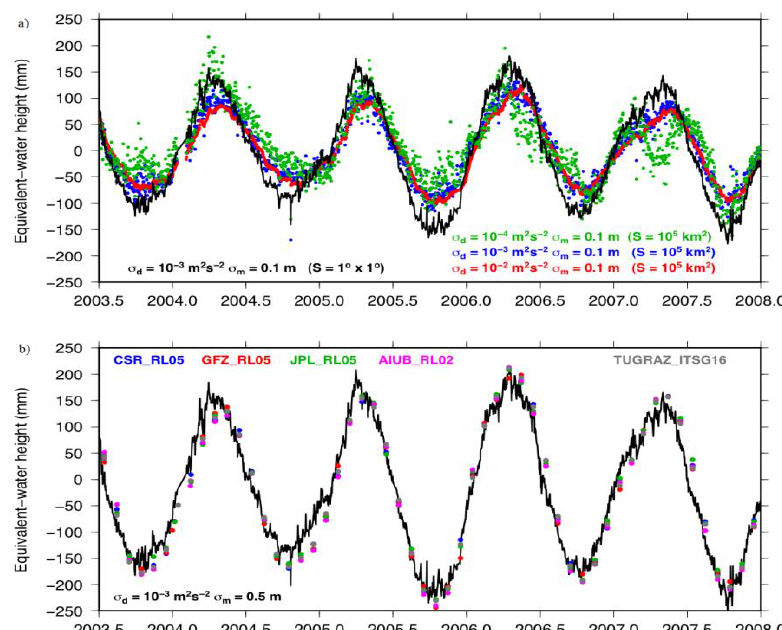
Figure 3. Amazon basin EWH time series: ( a ) for different sets of regularization parameters showing the impact of the surface element sizes; and ( b ) comparison with estimates of monthly solutions provided by the GRACE official centers.